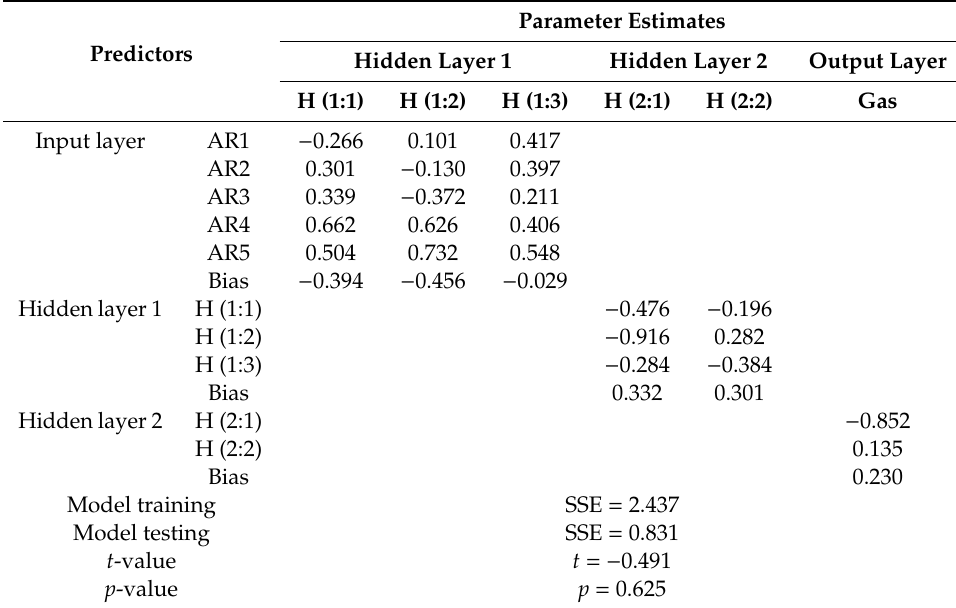
Table 7. The final ANN model summary for gas consumption in the residential sector.